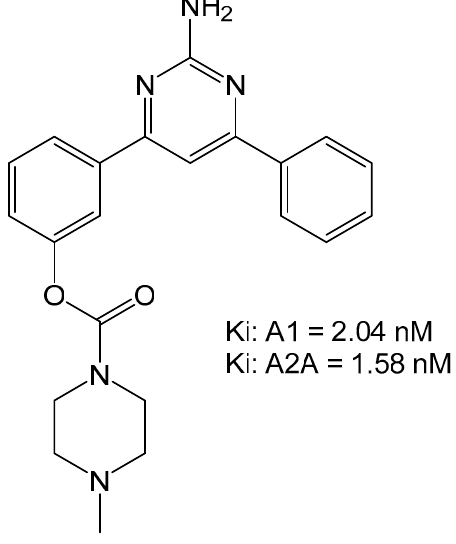
Figure 10. Carbamate-based adenosine receptor antagonists [34].